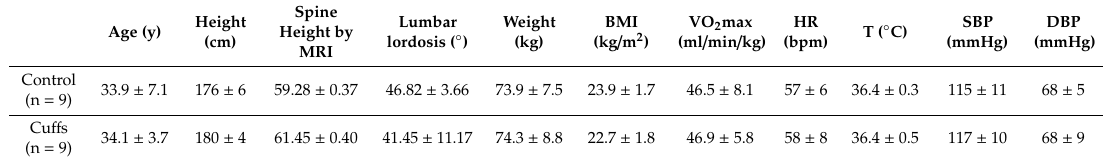
Table 3. Baseline group characteristics at B-2, mean ± standard deviation (SD). An unpaired T-test did not reveal any significant di ff erences between